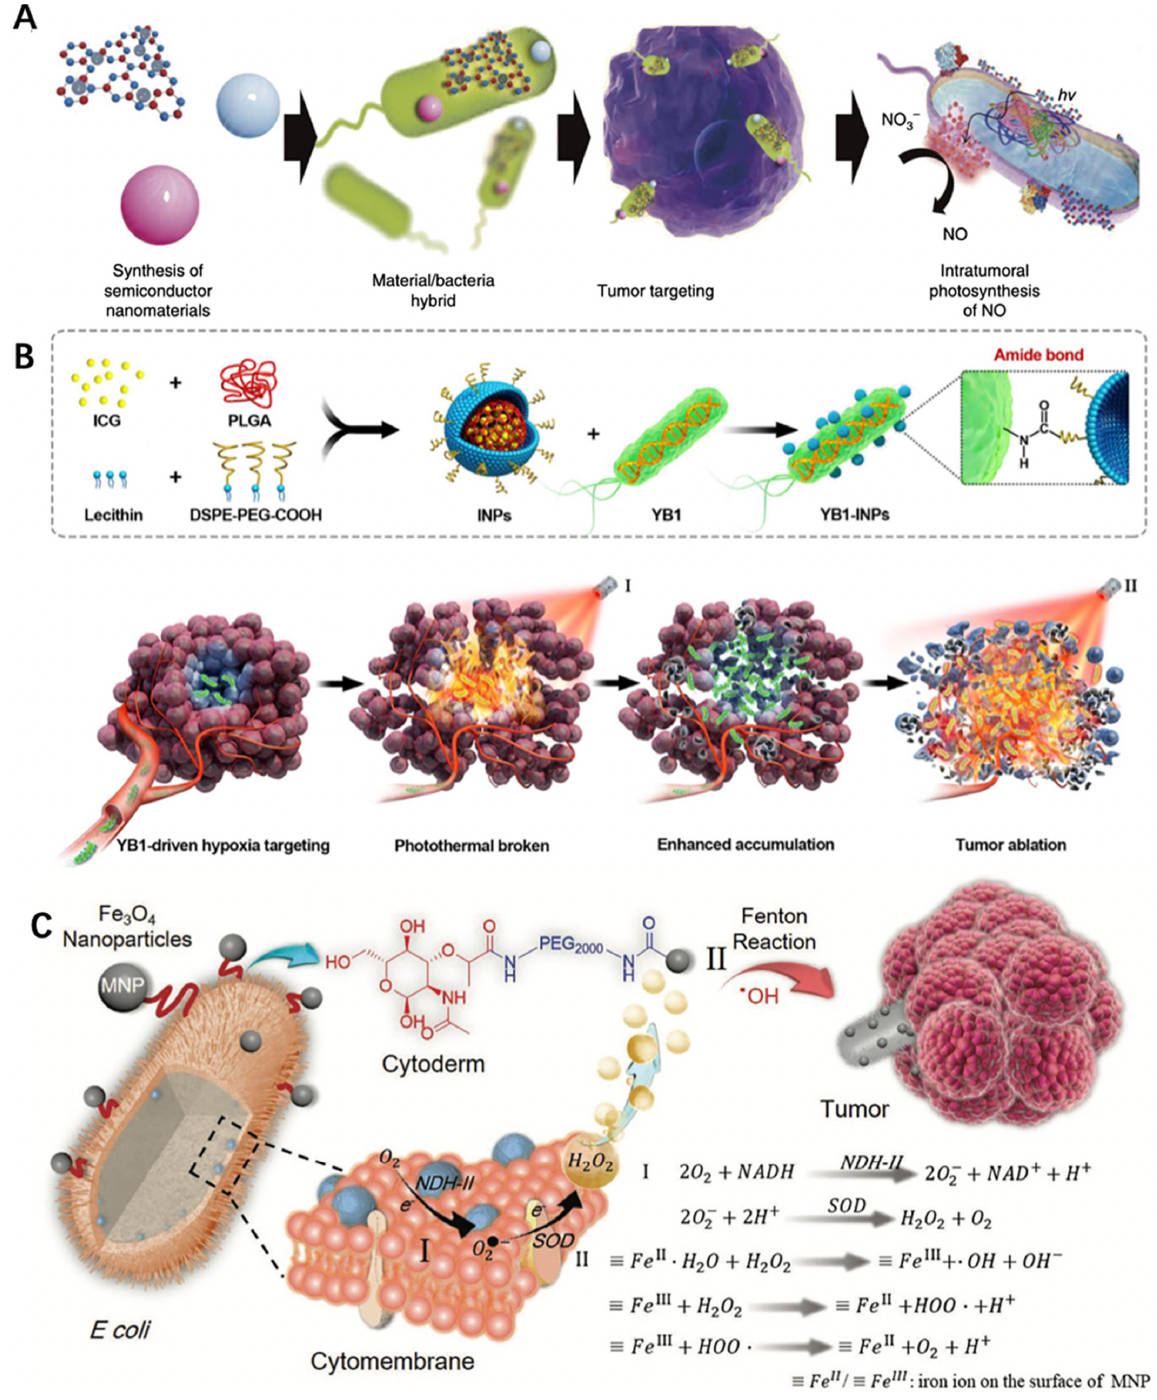
Figure 5. ( A ) Schematic diagram of photo-controlled bacterial therapy. Reproduced from [85], 2018, Springer Nature. ( B ) Preparation procedure of YB1–INPs. Synthesized INPs with single-step sonication were attached to YB1 through amide bonds. YB1–INPs with hypoxia-targeting and photothermal-assisted bioaccumulation for tumor penetrative therapy. After migration into tumor hypoxic cores and subsequent irradiation with a NIR laser, the loosening of the tumor tissue and tumor lysis generate bacteria-attracting nutrients, which further enhances the accumulation and coverage of YB1–INPs in large solid tumors. Ultimately, the enriched YB1–INPs under NIR laser irradiation completely ablated the large solid tumor without relapse. Reproduced with permission from [86], 2019, Elsevier. ( C ) The scheme of a bacteria-based Fenton-like bioreactor and its chemodynamic therapy process for antitumor therapy. Reproduced with permission from [87], 2019, WILEY-VCH Verlag GmbH & Co. KGaA,